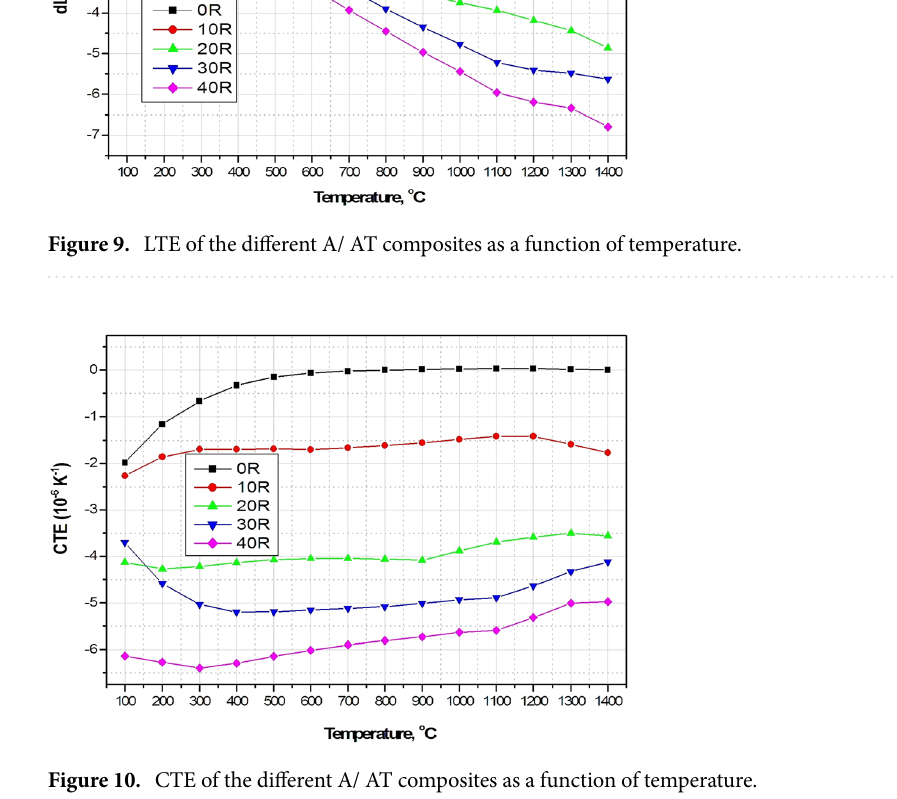
Figure 10. CTE of the different A/ AT composites as a function of